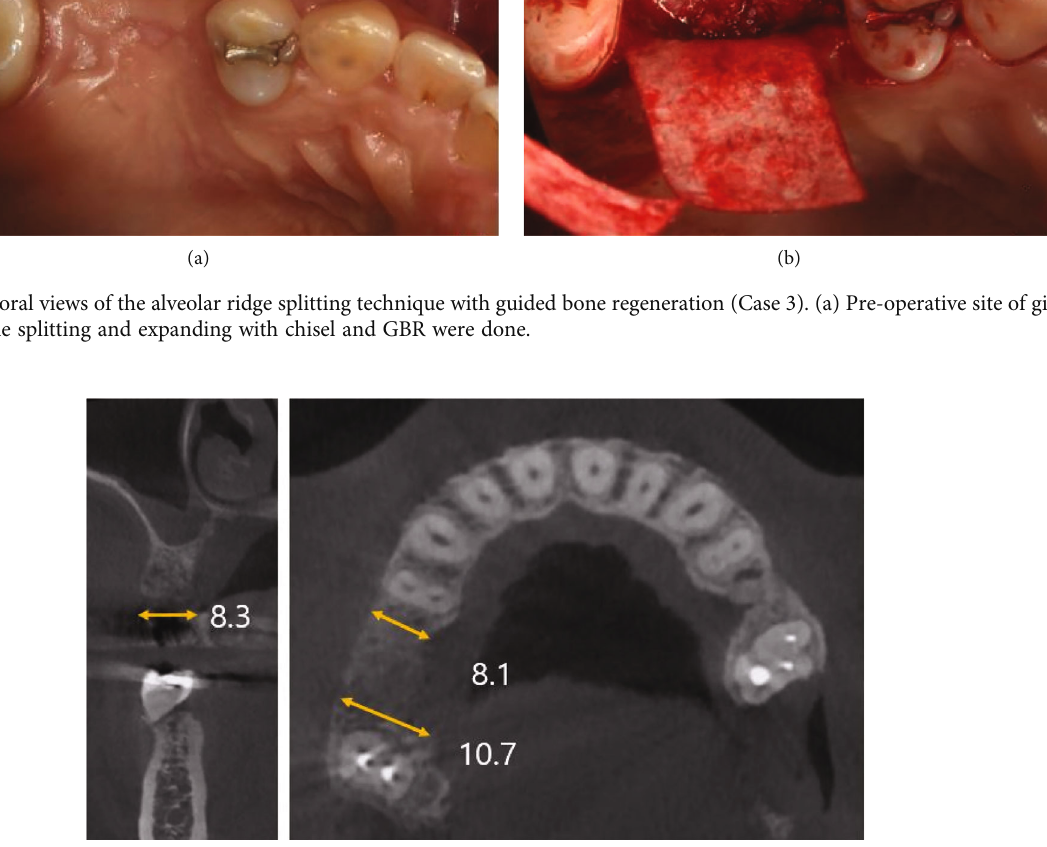
Figure 11: Postoperative CBCT view, showing that the width of the alveolar bone had increased (Case